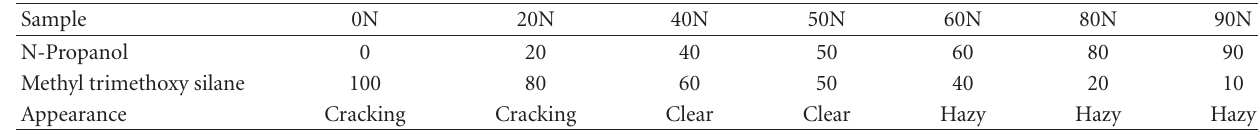
Table 1: The sol-gel formulation using N-propanol as solvent.